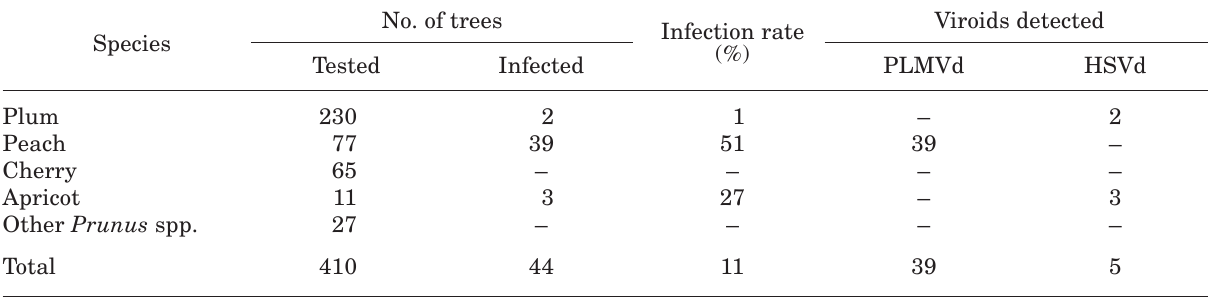
Table 1. Results of tissue-imprint hybridization (TIH) assays for PLMVd and HSVd.